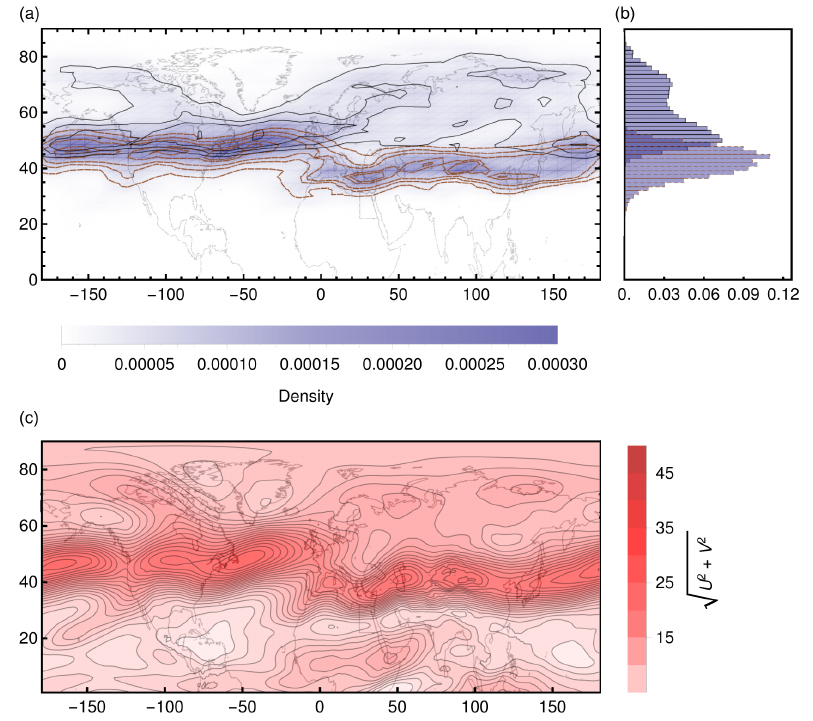
Figure 11. Probability analysis for summer months (JJA; compare with Fig. 10).